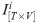
Detailed version of the fMRI data to the spatial maps process that elaborates the boxes “Dimensionality Reduction with 2-step PCA” and “Obtain Spatial maps Using PCA/k-PCA/ICA/NSD” in Fig 5.The first three of four steps show how 2-step PCA is applied to the data, where the concatenation step is temporal concatenation (Fig 7). The first column shows that the scan from subject i is a T × V matrix I[T×V]i. The next column, after “Subject Level PCA”, shows the ith subject is described as Y[Tred×V]i, with dimension Tred × V. The subsequent “Concatentation” step produces a group matrix with dimension nTred × V. The “Group Level PCA” step reduces this to a K × V matrix, which the “Source Separation” step factorizes to produce the mixing matrix size K × C. This final step could be the identify transformation, kernel-PCA, standard ICA or non-linear ICA; each of these might lead to different values of C.